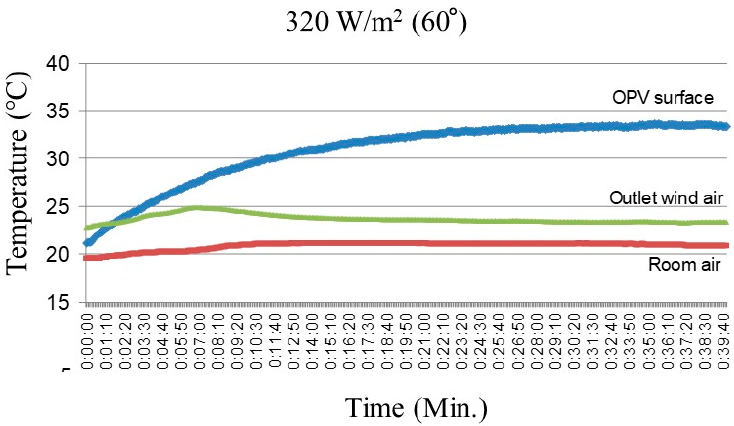
Figure 14. Temperature distribution in large-scale OPV-solar chimney as a function of time.